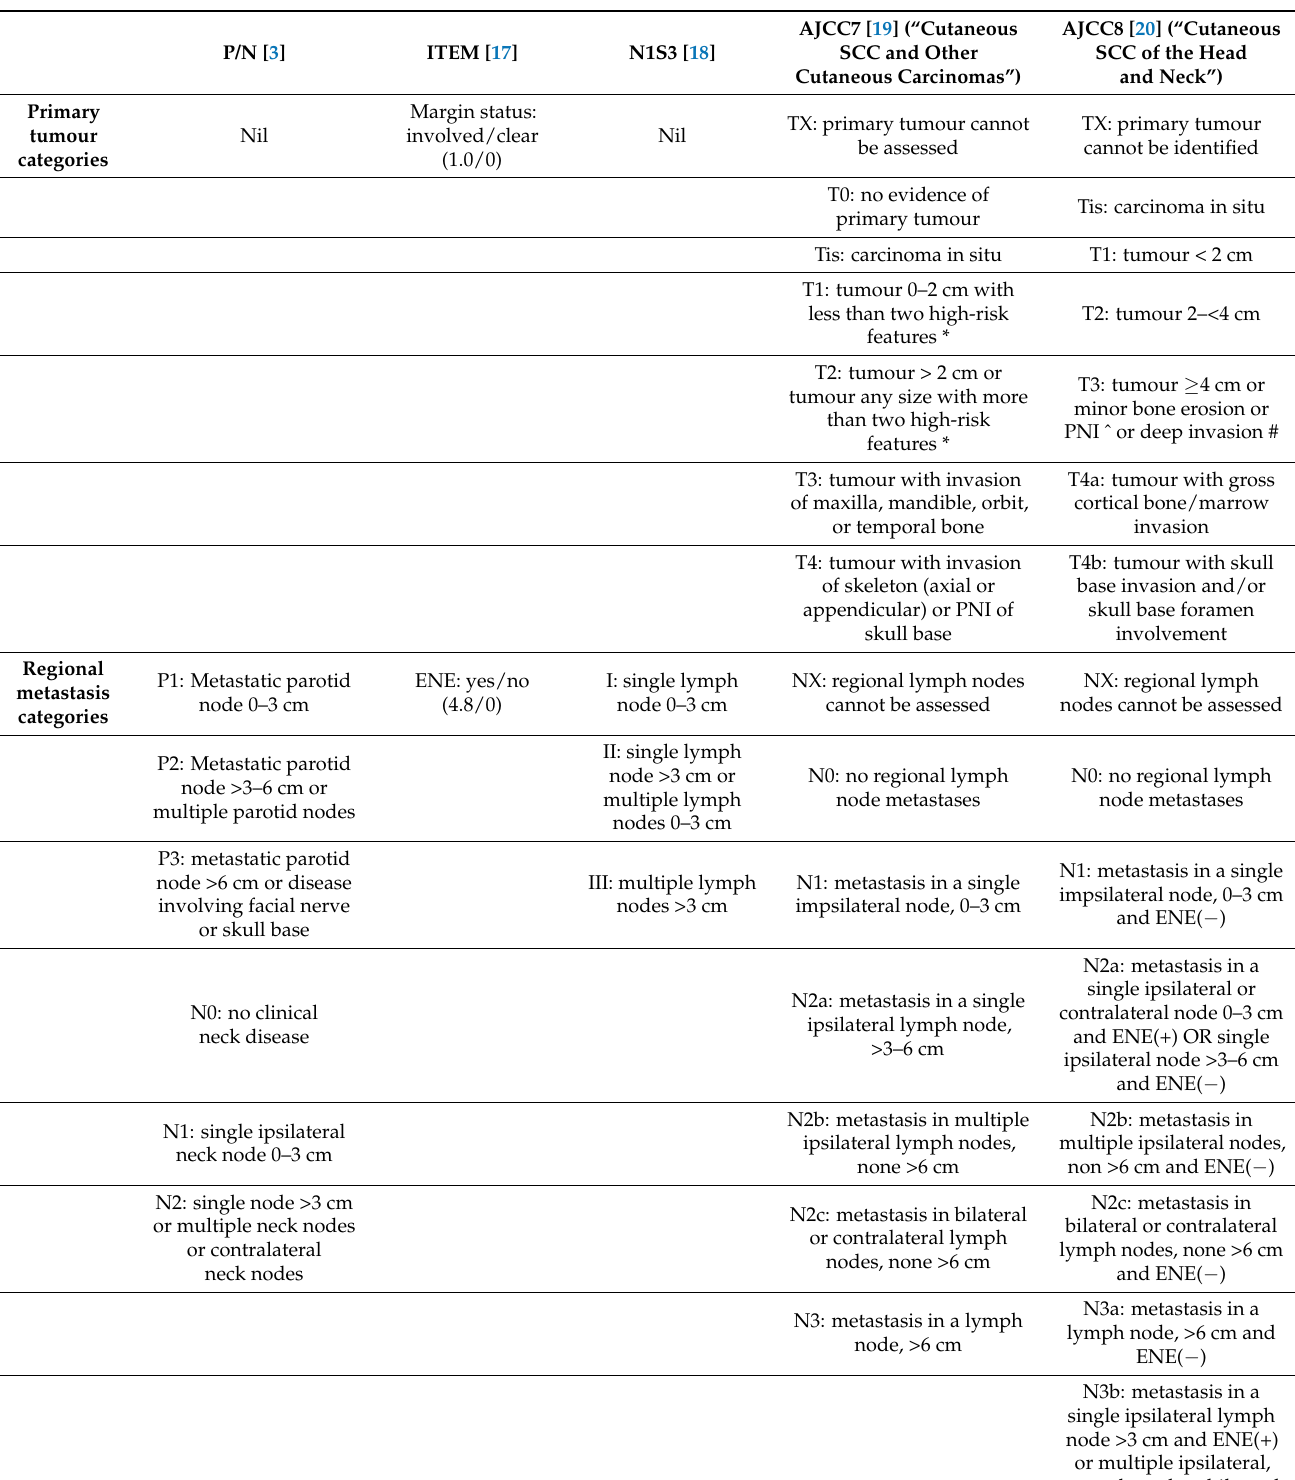
Table 1. Comparison of the P/N, ITEM, N1S3, AJCC7, and AJCC8 staging systems in relation to high-risk